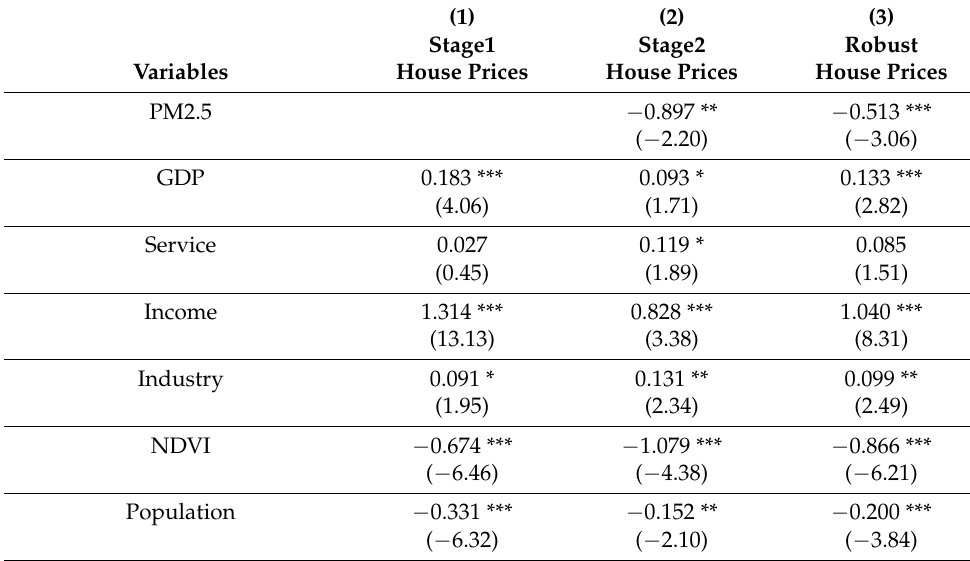
Table 5. The results of the robust